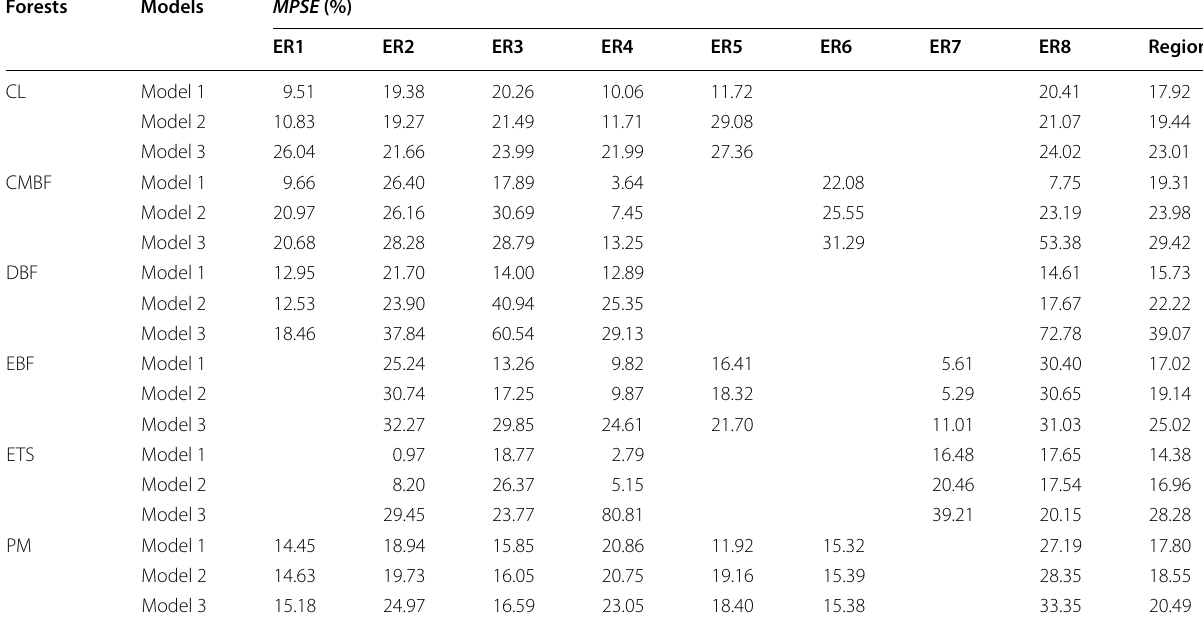
See Table 1 for the abbreviations of six forests and eight ecoregions